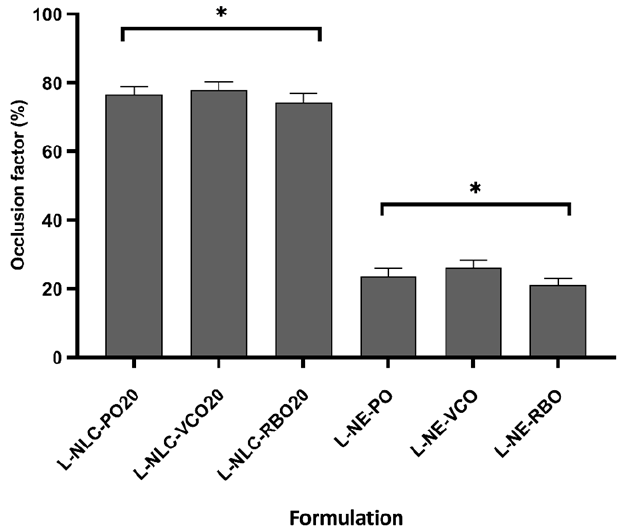
Figure 6. Occlusion factors of L-NLC and L-NE dispersions at 24 h. * Statistically significant differ- ence compared between L-NLC and L-NE ( p < 0.05). The data are expressed as the mean ± SD ( n = 3).